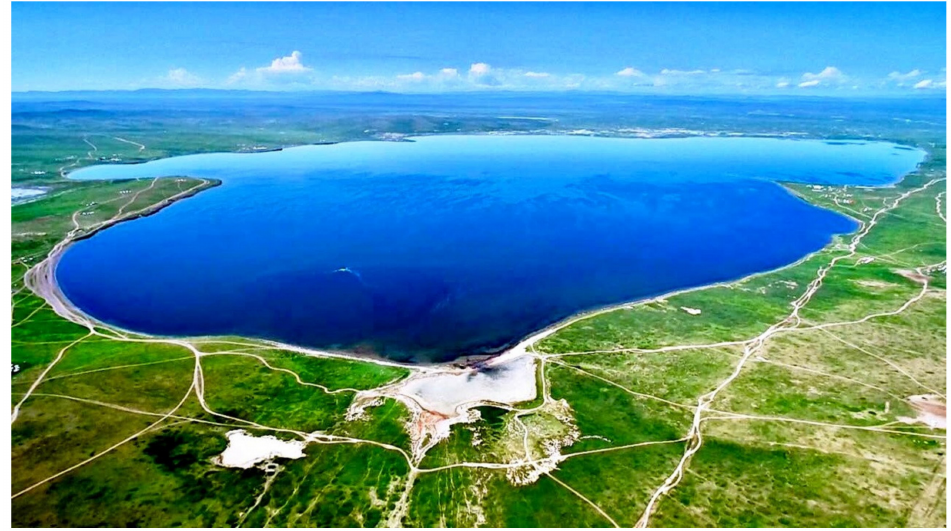
Figure 1. The Ugii Nuur Lake, northwest-facing view of the landscape in 2018. Photo by Uuganbat